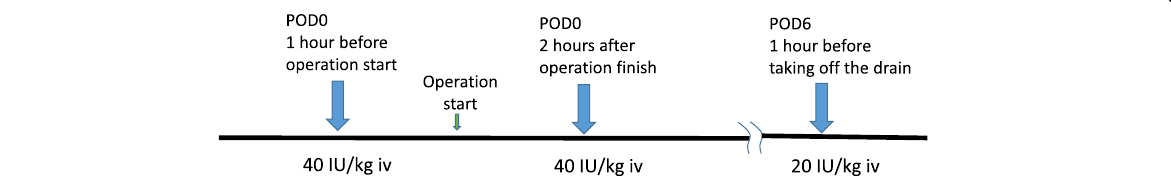
Fig. 2 Timeline of the perioperative management for administration of FVIII/VWF concentrates. IU, international unit; iv, intravenous dosage; POD, postoperative day